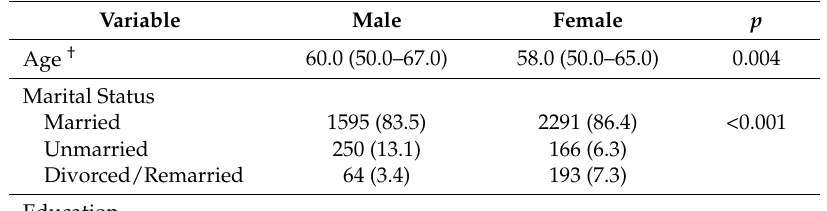
Table 1. Characteristics of the study participants stratified by sex in rural areas of Ningbo, China between March and May